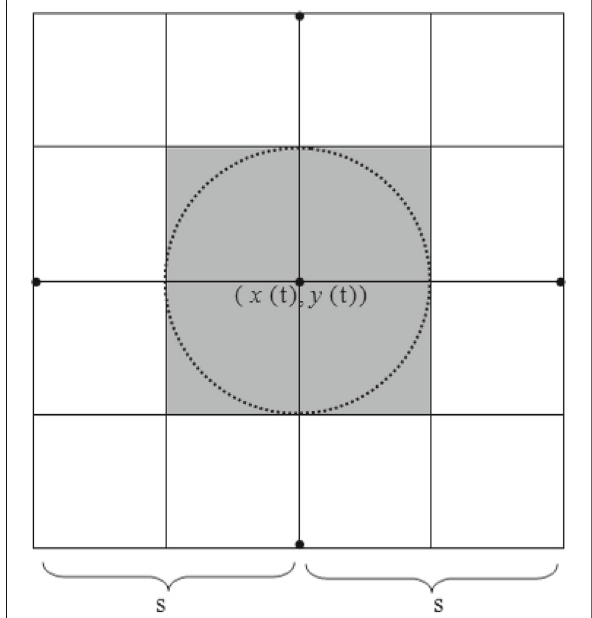
[27] in terms of accuracy and computational complexity.